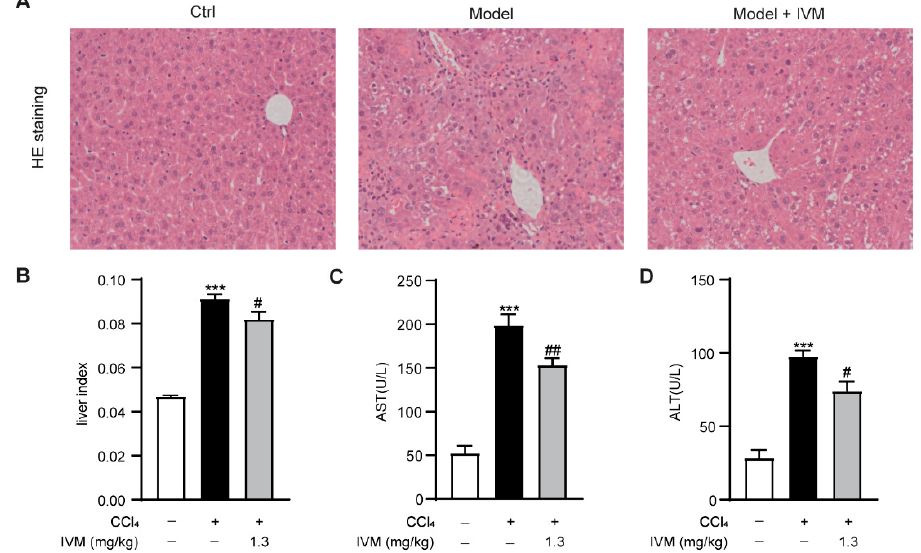
Figure 1. Effects of ivermectin on CCl 4 -induced hepatic pathological and biochemical parameters in mice: ( A ) liver tissues were stained with hematoxylin and eosin (HE) for the histopathological analysis (original magnifications, × 200); ( B ) liver index values; ( C , D ) plasma AST and ALT levels. Data are expressed as means ± SEM ( n = 6–8/group). Note: *** p < 0.001 vs. control group, # p < 0.05, ## p < 0.01 vs. CCl 4 -treated model group.